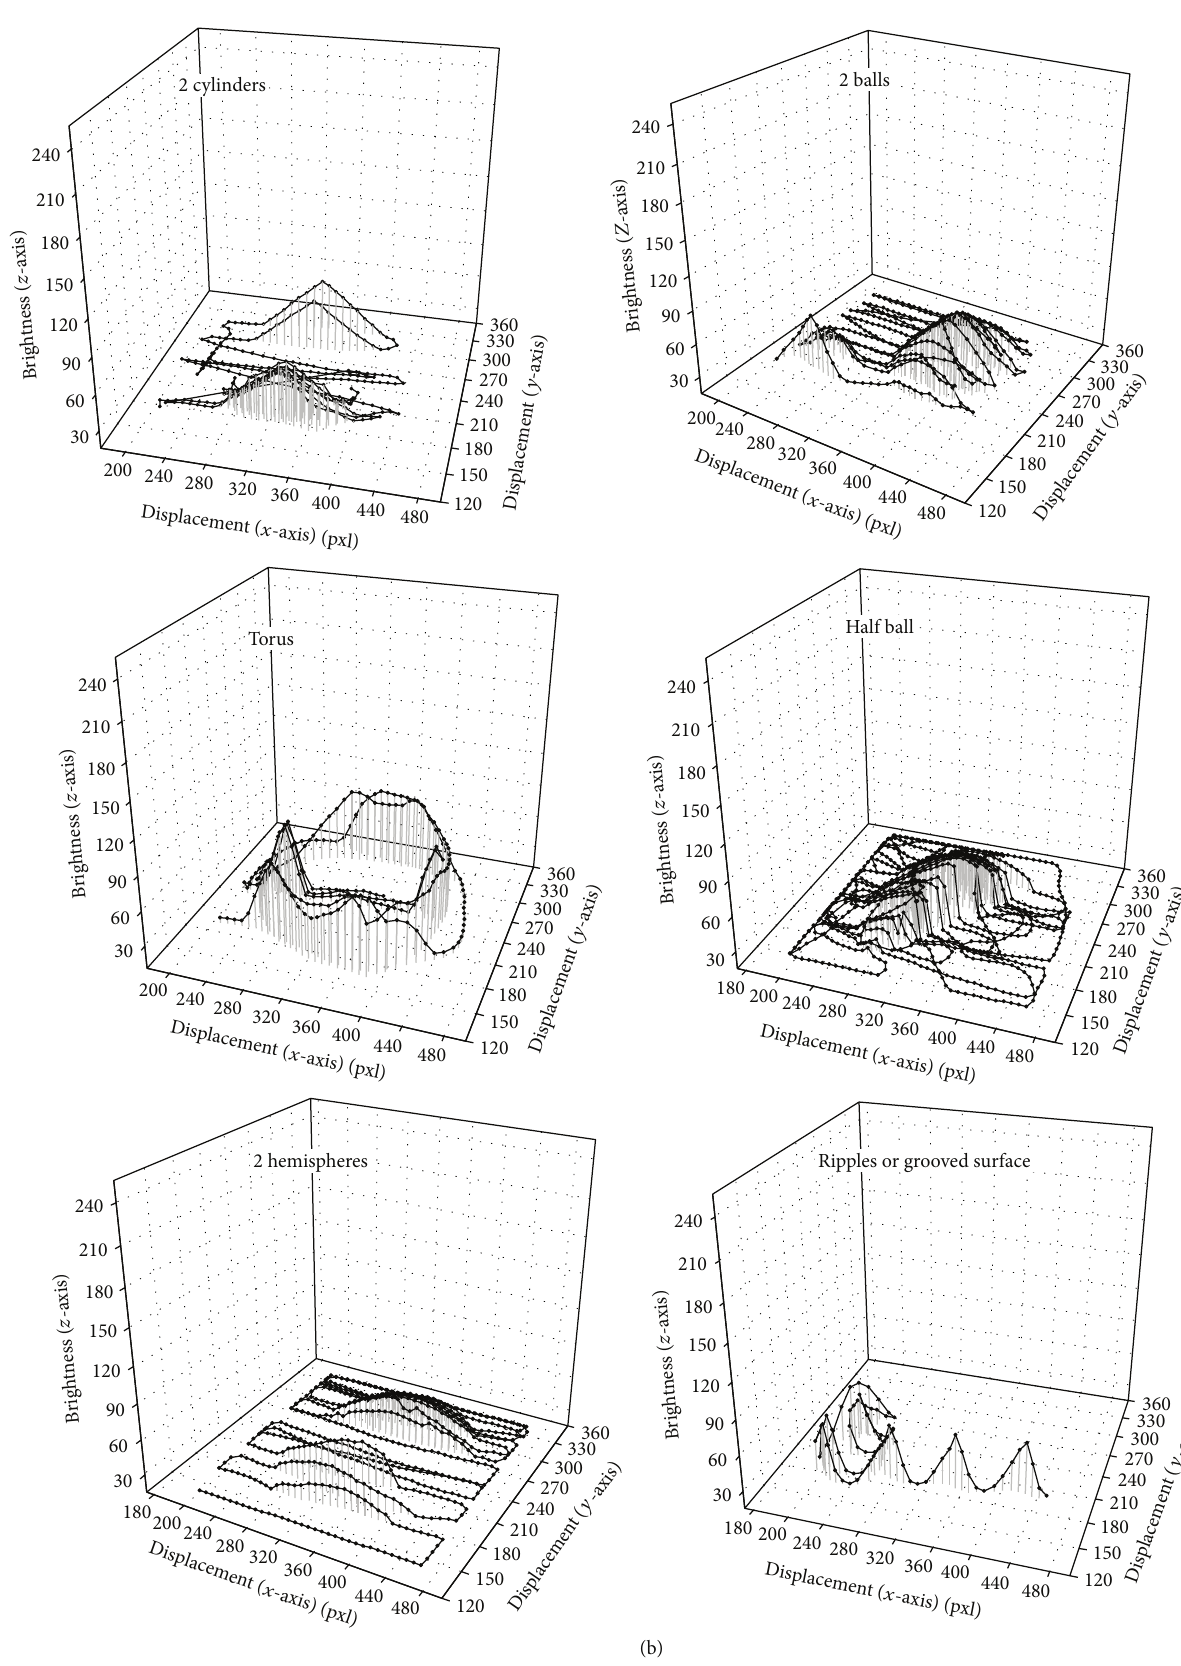
Figure 4: (a) Typical tracks recorded during haptic exploration and identification of virtual shapes in the free scanning mode. (b) 3D reconstruction of the virtual shapes explored in the free scanning